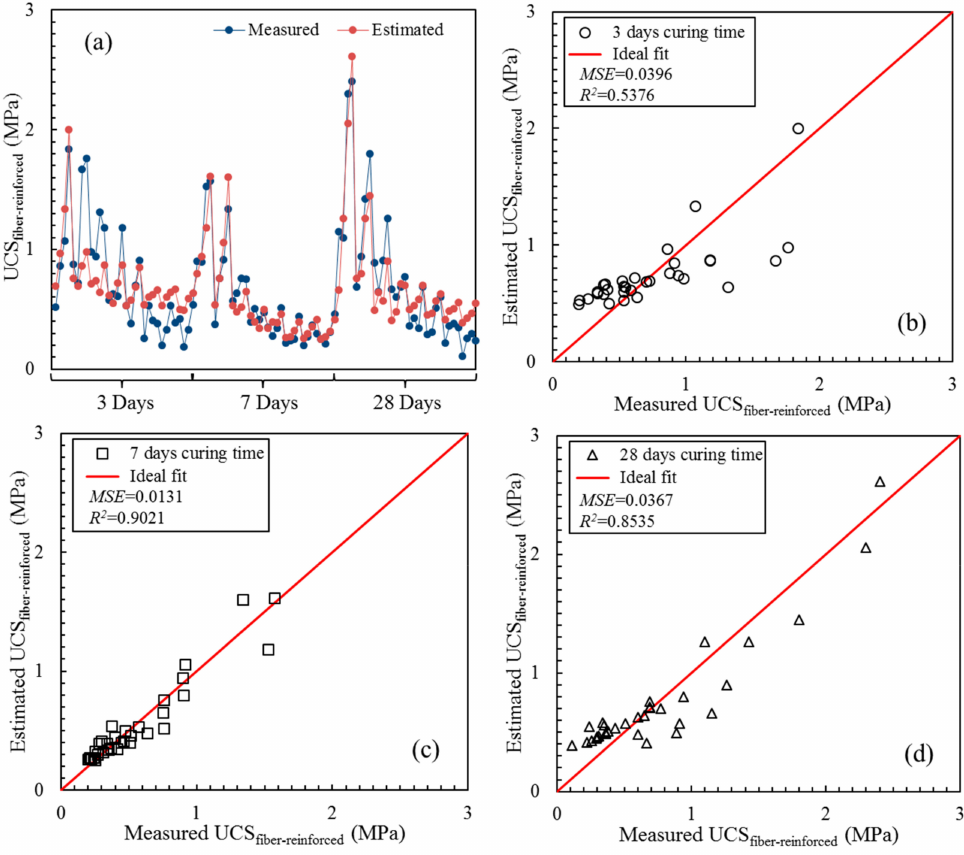
Figure 12. Estimated value of the UCS fiber-reinforced based on composite mechanics and its regression with measured values with di ff erent curing times: ( a ) measured values and estimated values; ( b ) 3 days curing time; ( c ) 7 days curing time; ( d ) 28 days curing